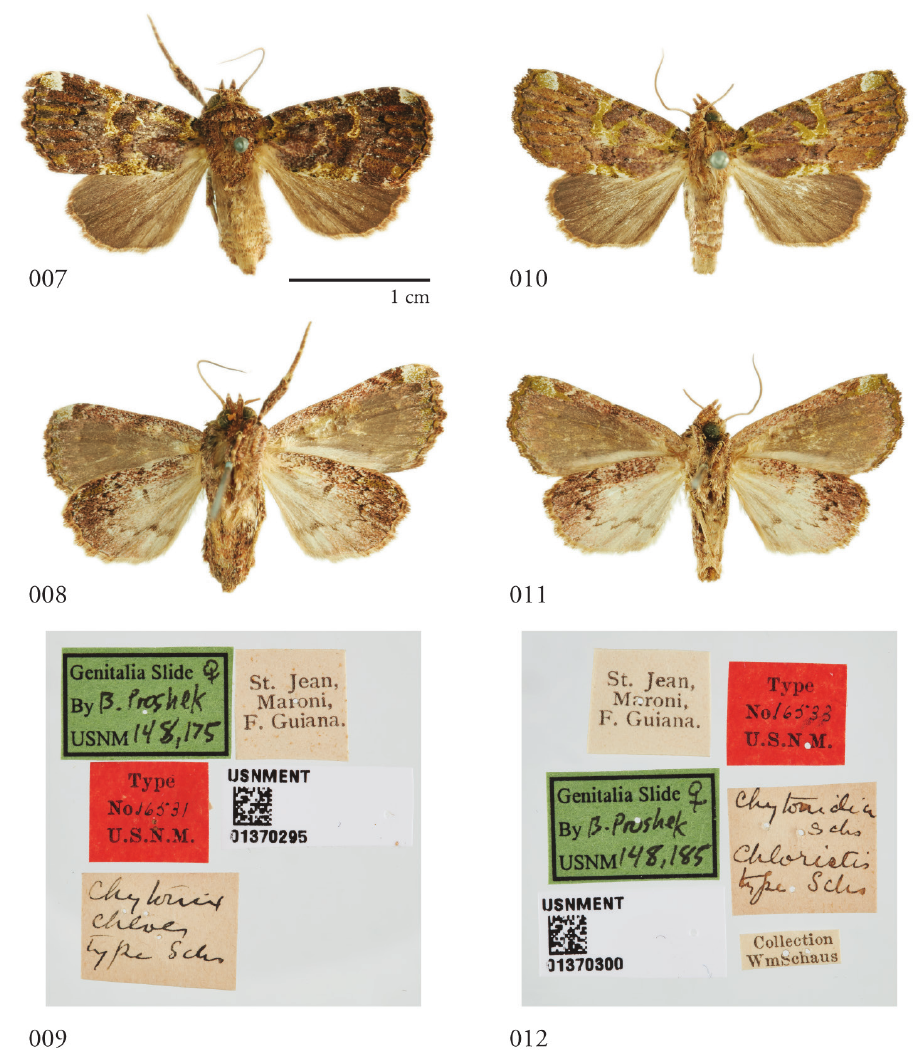
Figures 7–12. Dorsal and ventral habitus and specimen labels of female holotypes of Chytonix chloe (7–9) and its synonym Chytonidia chloristis (10–12)